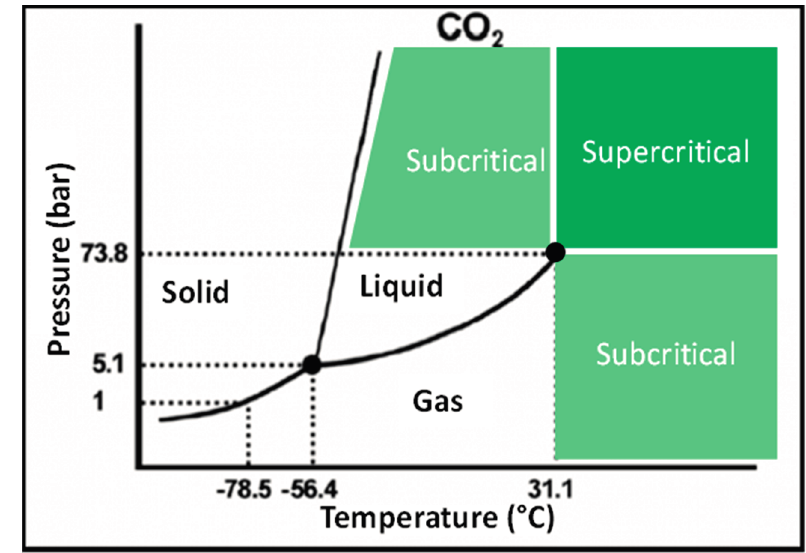
Figure 1. Pressure-Temperature phase diagram of CO 2